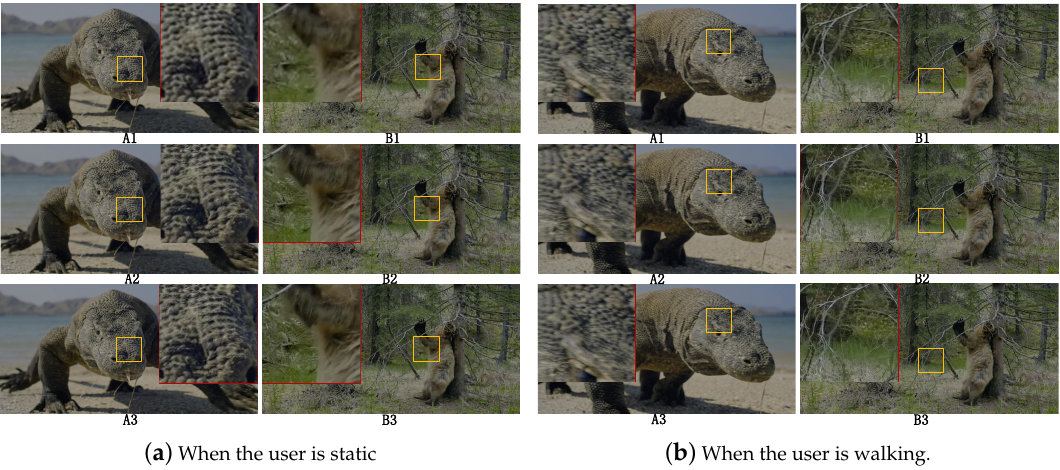
Figure 8. Images in video frame comparison results.